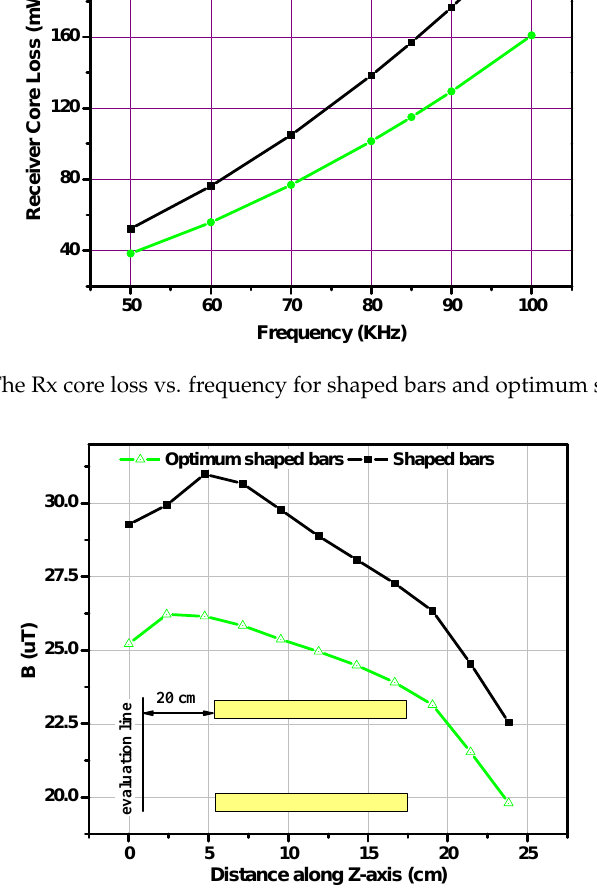
Figure 15. B _ Mag . along a line located vertically, 20 cm from the pad edge for shaped bars and optimum shaped bars.